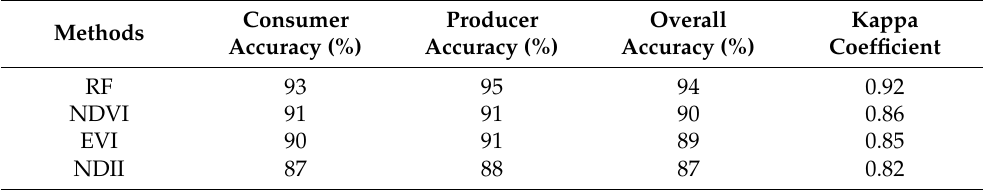
Table 1. Evaluations results for the detected damaged forest area based on RF and UID-VI methods.